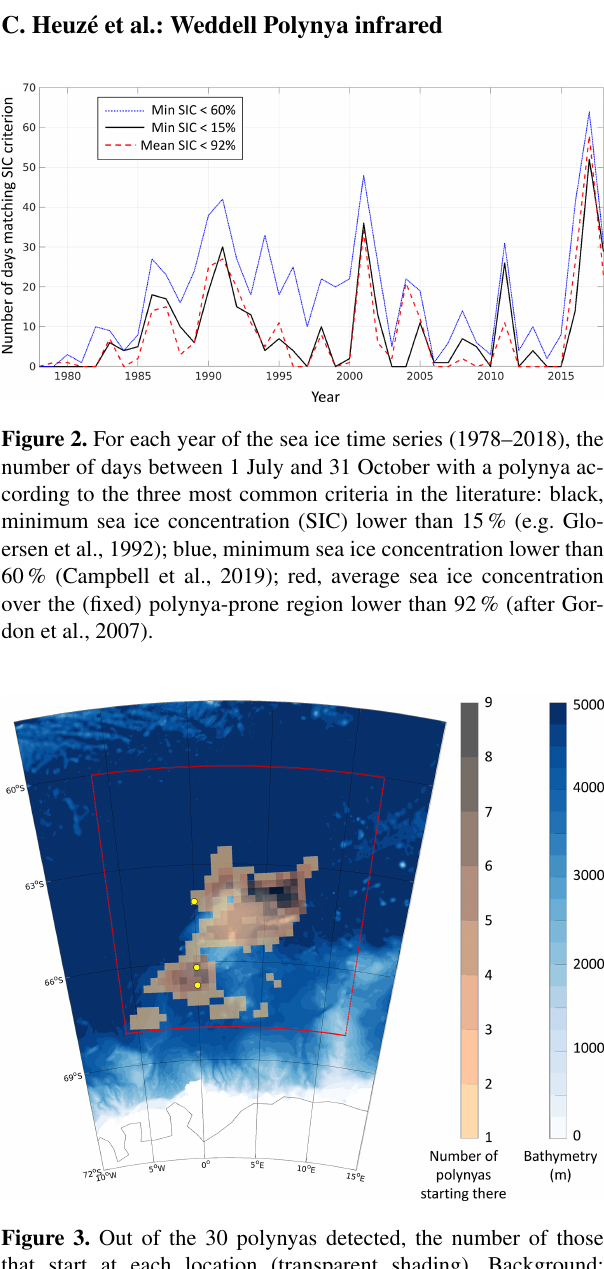
which yields 30 polynyas because five events have two to four polynyas in the region simultaneously. Note that all du- rations make the polynya disappear on 1 November because of our end-date